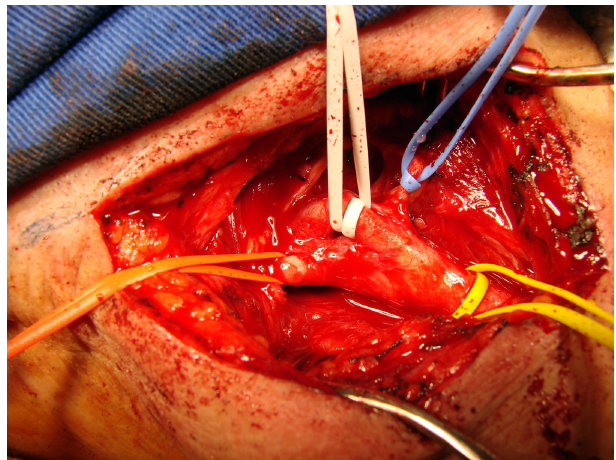
Fig. 1 - Surgical dissection: common carotid artery (yellow strip), external carotid artery (white strip) and internal carotid artery (red strip).